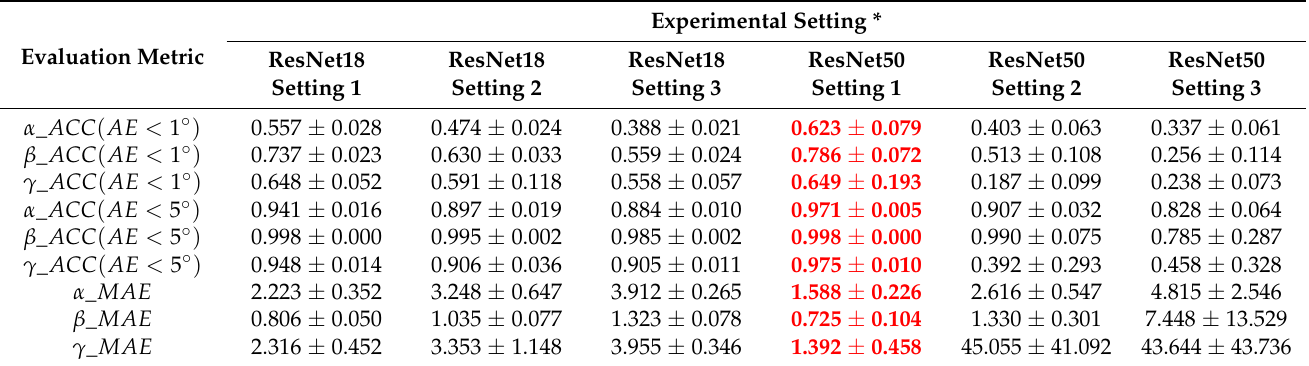
Table 5. Performance of different model structures and initialization mode analysis. The optimal results are tabulated in red.